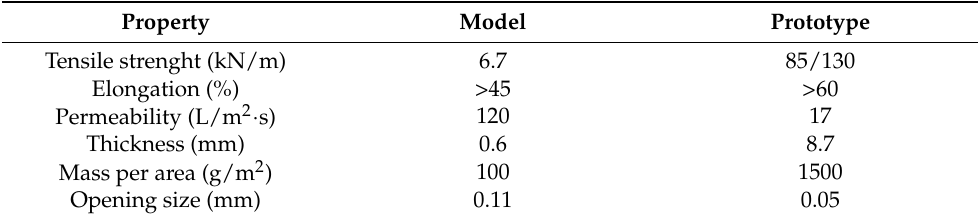
Table 1. Properties of nonwoven geotextile material in the model and in the prototype.